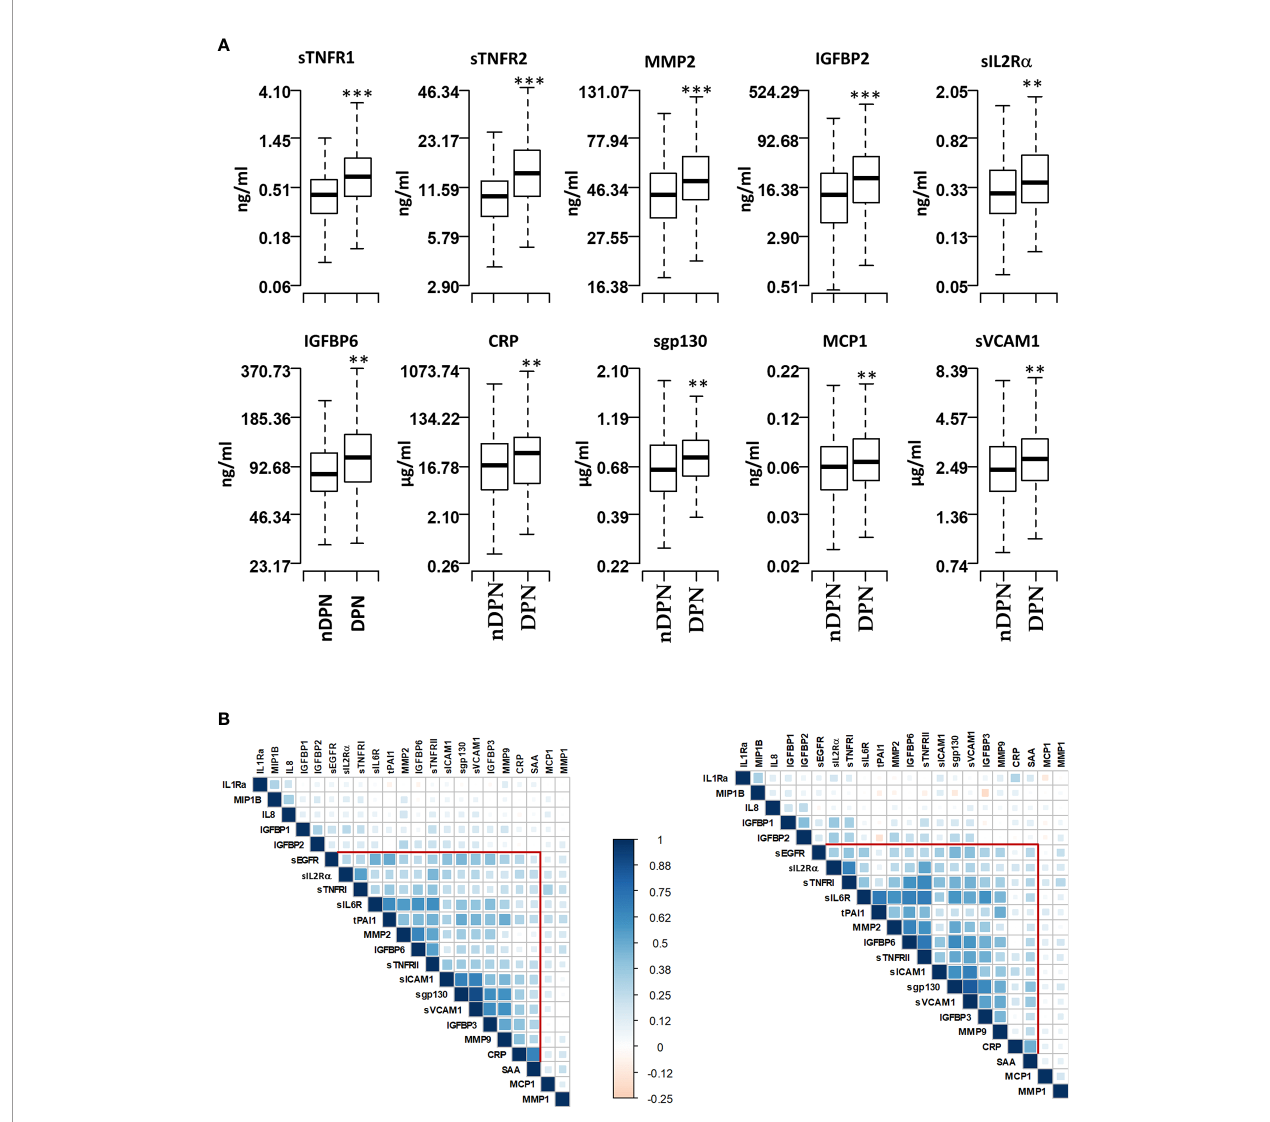
FIGURE 1 | Serum levels of proteins and pairwise correlations. (A) Boxplots showing the measured levels of selected proteins in T1D patients without diabetic neuropathy (nDPN, n=507) and with diabetic neuropathy (DPN, n=187). (B) Heatmaps showing the pairwise correlation coef fi cients in nDPN (left) and DPN (right) patients. The correlation coef fi cients are clustered based on the supervised hierarchical clustering. The color density represents the strength of correlation (r) values and the size of the squares represent the signi fi cance. ***P < 0.000001, **P <